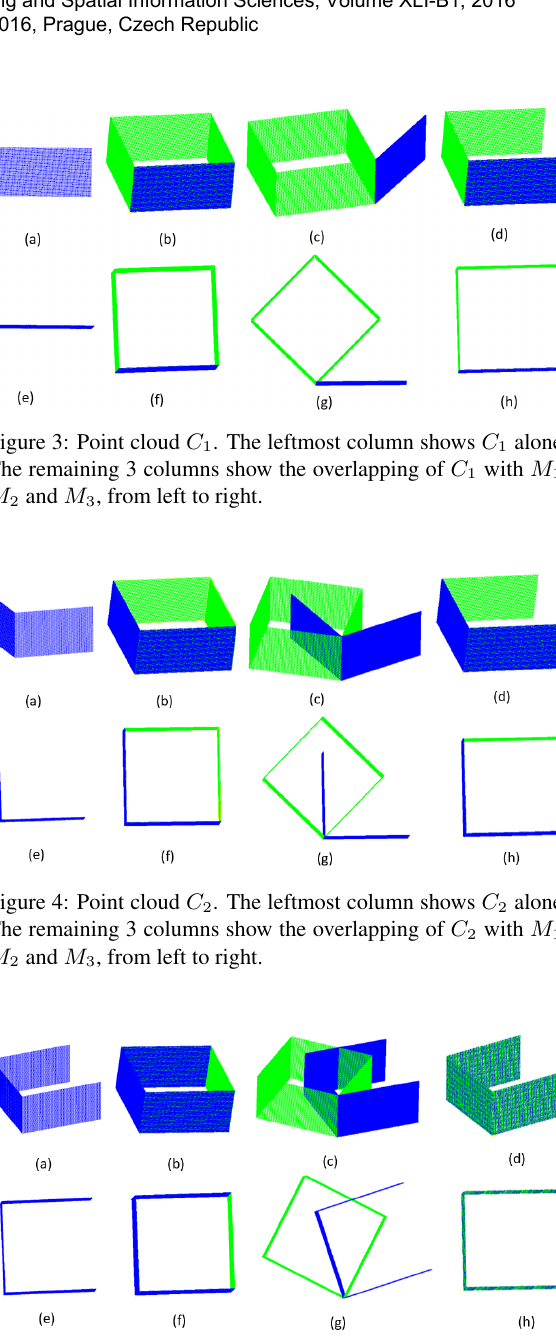
Figure 5: Point cloud C 3 . The leftmost column shows C 3 alone. The remaining 3 columns show the overlapping of C 3 with M 1 , M 2 and M 3 , from left to